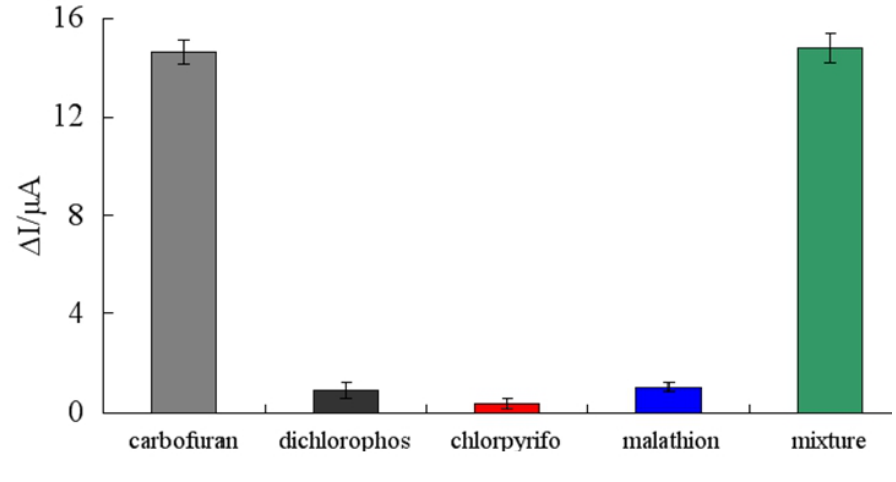
Figure 6. Specificity of immunosensor in the presence of dichlorophos (10 μ g/mL), chlorpyrifos (10 μ g/mL), malathion (10 μ g/mL), carbofuran (10 μ g/mL) and the mixture of carbofuran and the three kinds of interferences stated above.